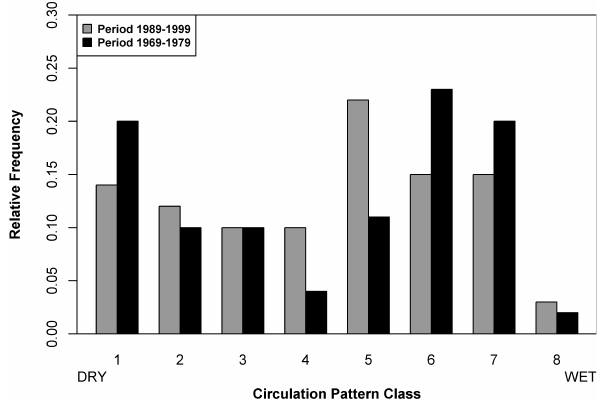
Fig. 5. Relative frequencies of circulation pattern classes for days with available hourly rainfall records in the periods 1989–1999 (pa- rameterization period) and 1969–1979 (validation period).